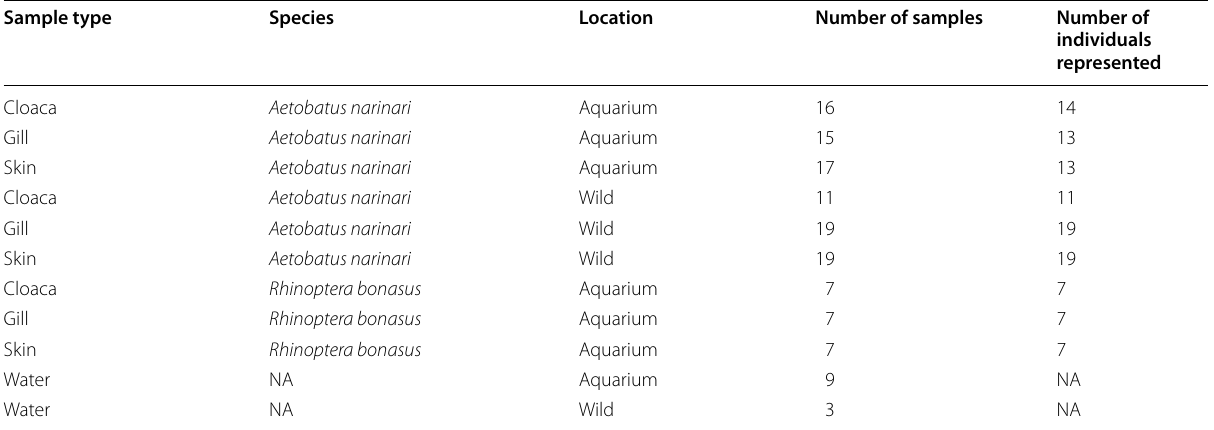
Table 1 Summary of the number of samples collected and the number of individuals sampled according to body site, ray species, and